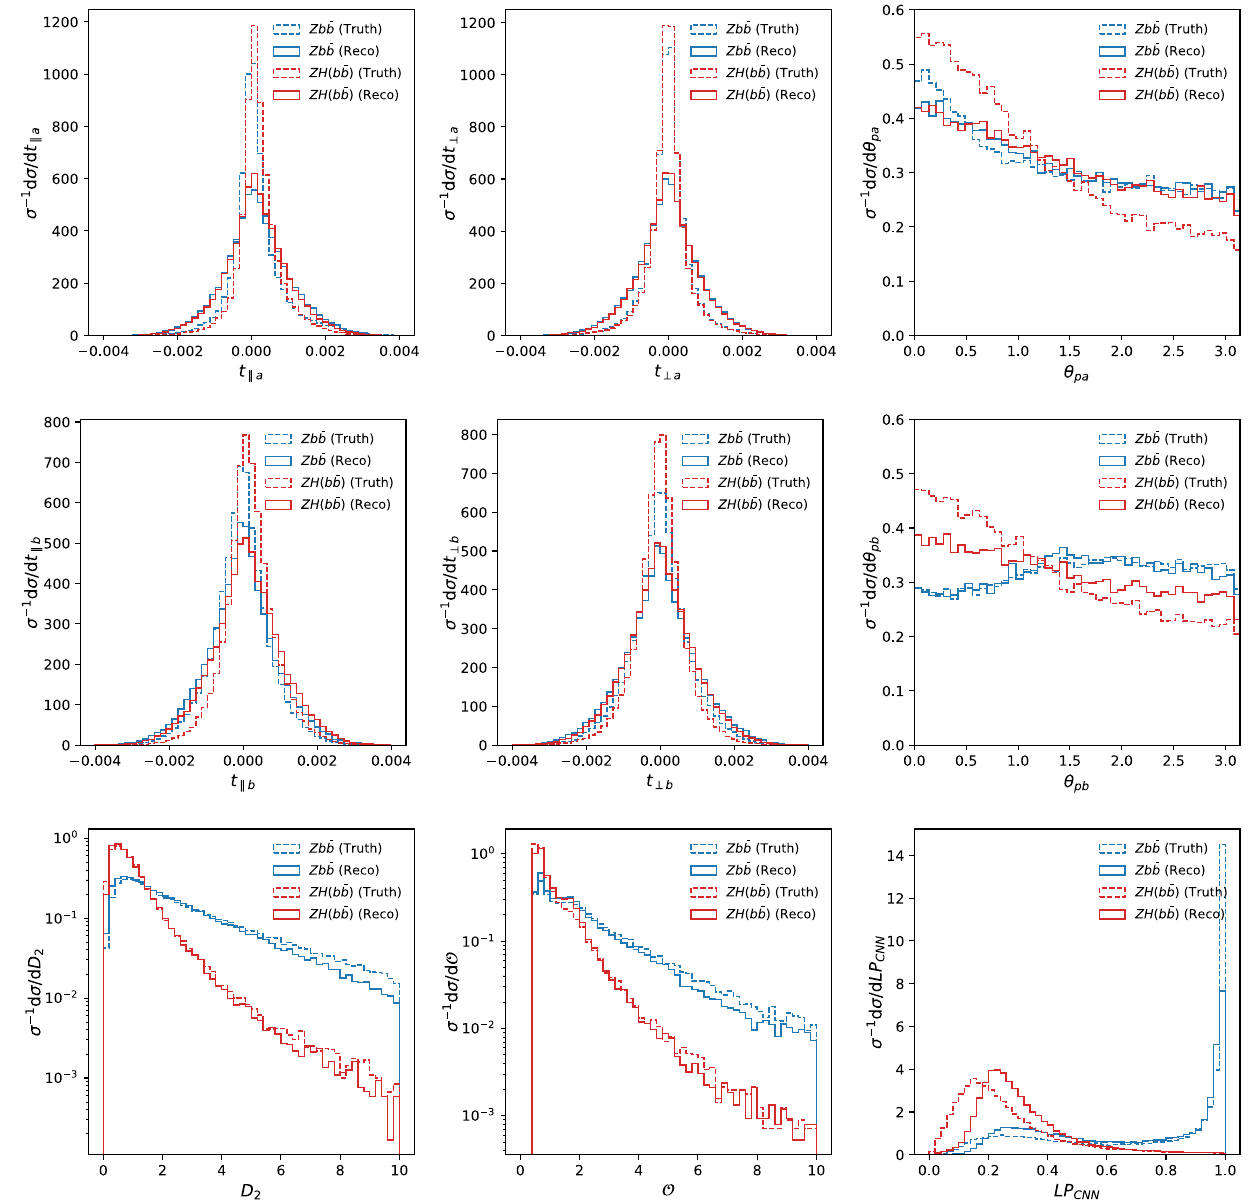
Fig. 2 The distributions of the colour sensitive variables and Lund jet plane after the selection cuts. Signal ( Z H ( b ¯ b ) ) and background ( Zb ¯ b ) distributions are shown in red and blue, respectively, for both truth and reco